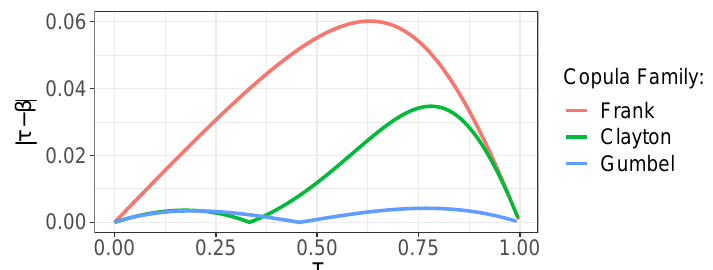
Figure 1: Absolute difference | τ − β | as a function of τ for the Frank, Clayton and Gumbel–Hougaard